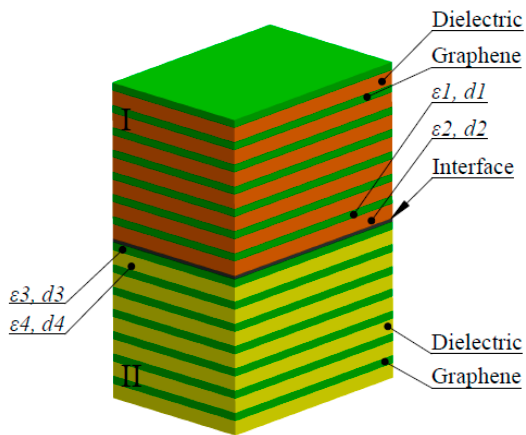
Figure 2. A schematic diagram of the boundary surface separating two different infinite multilayered MMs designed by a stack of periodically changing graphene and dielectric layers. Here, dielectric and graphene sheets are denoted by indexes “1, 2”, correspondingly.